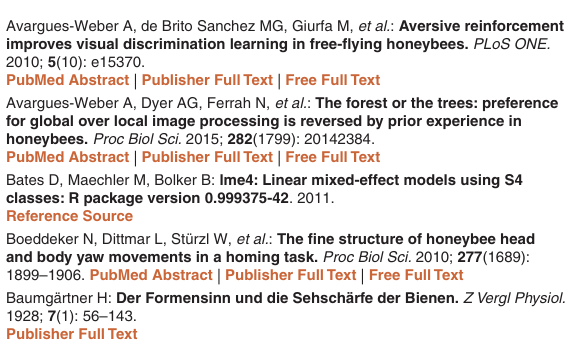
figshare : New datasets for strategies of Apis mellifera during visual search for vertical targets, doi: http://dx.doi.org/10.6084/ m9.figshare.1297290 (Morawetz et al. ,